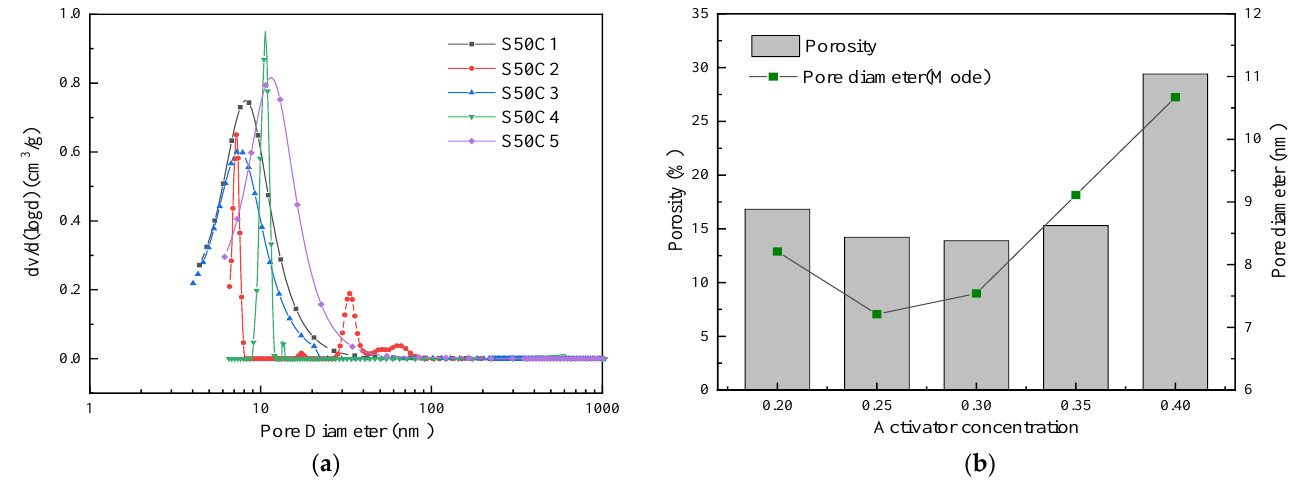
Figure 8. Results of MIP of alkali-activated composite cementitious materials under different activator concentrations: ( a ) pore size distribution; ( b ) porosity and the pore diameter (mode). It can be seen from Figure 8 that the pore size distribution does not differ greatly under different activator concentrations, and the pore size is mainly distributed at about 10 nm. With the increase in the excitation concentration from 0.20 to 0.40, the porosity first minimum value of 13.89%. When the activator concentration is 0.20, the most probable pore size is 8.21 nm, and the porosity is 16.83%. When the activator concentration is 0.25 and 0.30, the most probable pore sizes are 7.21 nm and 7.54 nm, and the porosity is 14.21% and 13.89%, respectively. The most probable pore size of 0.25 activator concentration is smaller than that of 0.30 activator concentration. However, it can be seen from Figure 8a that there is a pore size of about 30 nm in the 0.25 activator concentration, resulting in a porosity greater than 0.30 activator concentration and a compressive strength less than 0.30 activator concentration. When the concentration of the alkaline activator continues to increase to 0.40, the most probable pore size is 10.67 nm, the porosity is 29.41%, and both show an increasing trend. The above results show that, by adjusting the activator concen- tration, the amount of gel generated in the system can be increased and the proportion of gel pores can be increased. The pore size distribution of the structure can be refined, and the strength of alkali-activated cementitious materials can be improved [7]. However, compared with slag, the activator concentration has less of an influence on the pore struc- ture of alkali-activated cementitious materials. 3.6. Microscopic Morphology Analysis The micromorphology of alkali-activated fly ash–slag composite cementitious mate- rials under different slag content and activator concentrations at day 7 is shown in Figures 9 and 10.